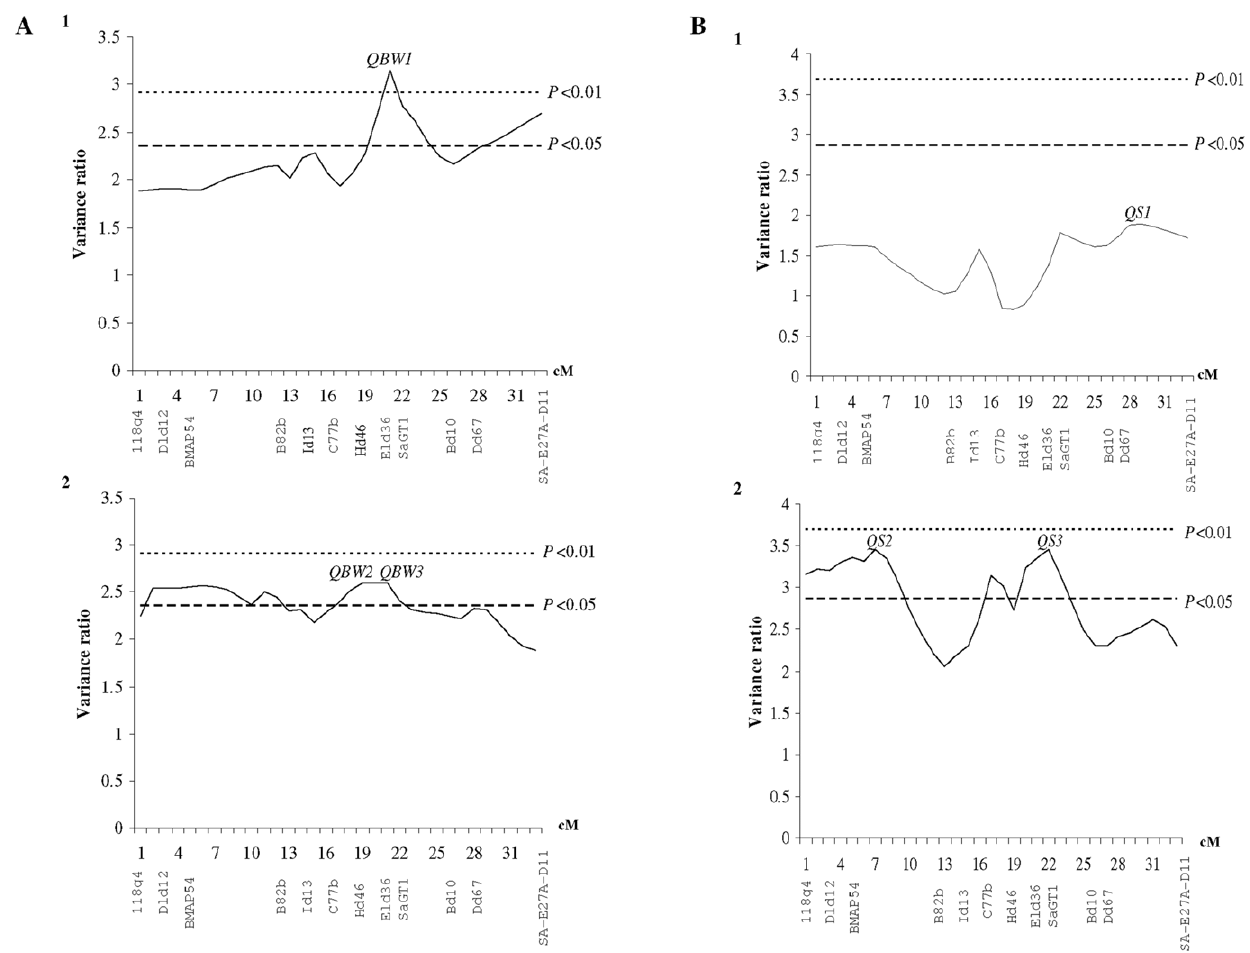
Figure 2. Quantitative trait loci for sex and growth. A. Mapping of QTL for body weight in Sparus aurata LG21: 1. One-QTL model for body weight; 2. Two-QTL model for body weight. B. Mapping of QTL for sex in Sparus aurata LG21: 1. One-QTL model for sex; 2. Two-QTL model for sex. doi:10.1371/journal.pone.0016599.g002 Table 3. QTL variance ratios ( F -statistic) and significance critical values (determined by permutations, Churchill and Doerge, 1994) at 1% and 5% levels for body weight and sex obtained in one and two QTL models for S . aurata linkage group 21 (LG21).